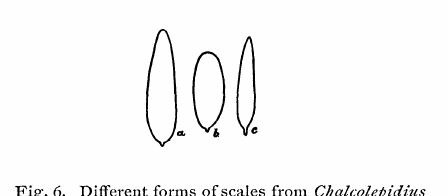
Fig. 6. Different forms of scales from Chalcoletidius rubr@ennis. Enlarged IOO diameters. nated from above they are brilliant with blue, red and green, the color depending upon the position of the surface of the scale with reference to the light. Put in direct sunlight, on a black surface, and the microscope focussed somewhat above them, the light is decomposed in fine lines of brilliant blue, green and red, as if series of solar spectra were drawn up near each other, thus indicating striation of the